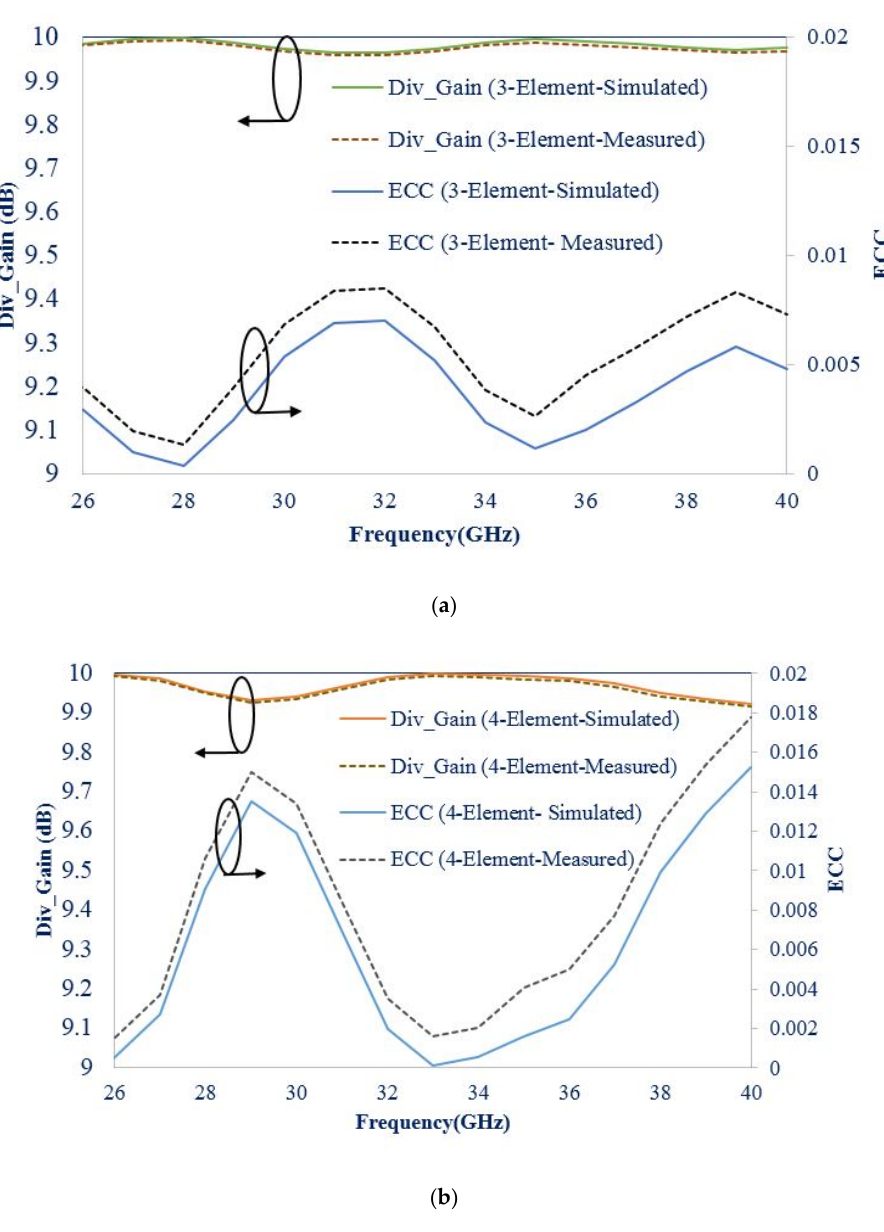
Figure 18. DG and ECC value of the proposed antenna: ( a ) three elements; ( b ) four elements.